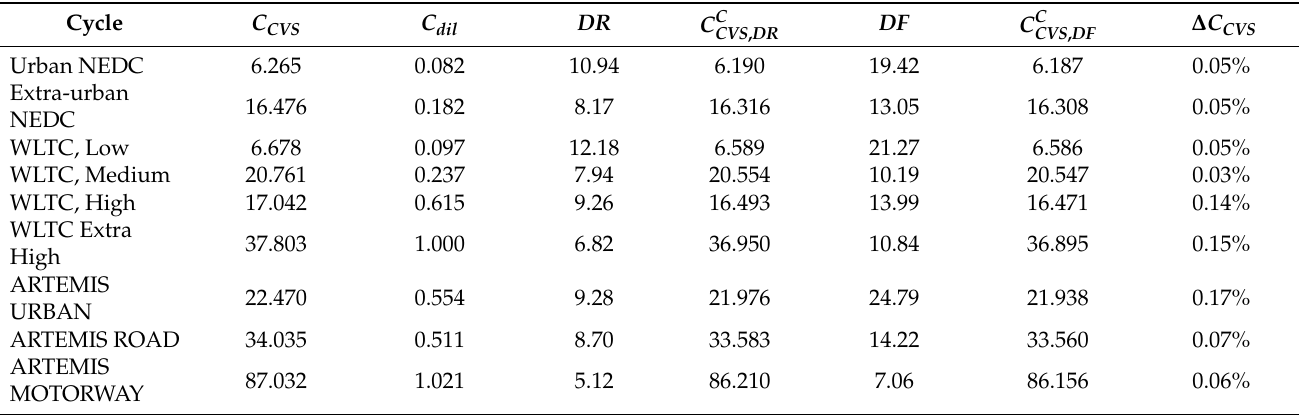
The C CVS,corr calculated based on Equations (5) and (21) for Euro 5 vehicle with CI engine, NO x concentration